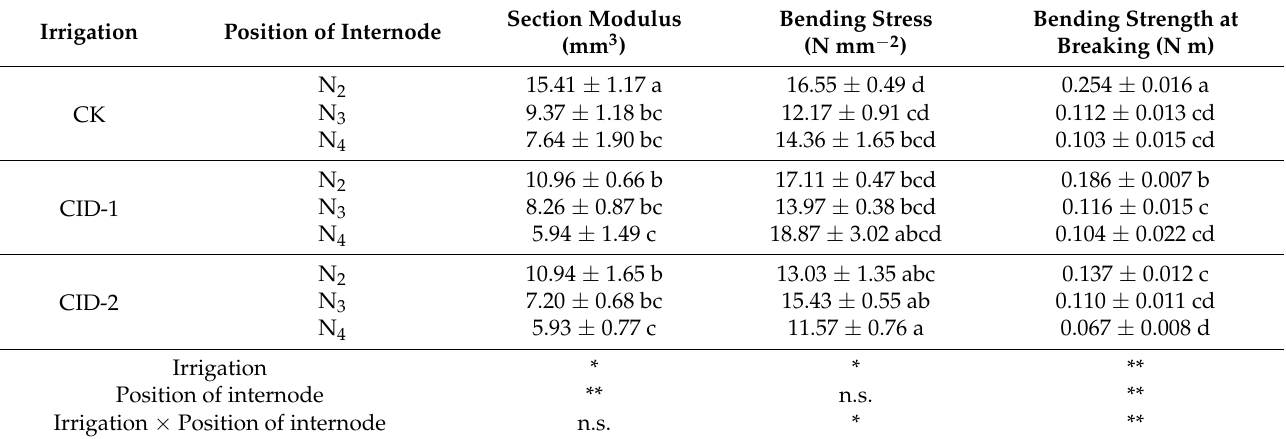
Table 3. The output of one-way and two-way analysis of variance (ANOVA) for section modulus and bending stress under different irrigation regimes and position of internode during the rice growing season of